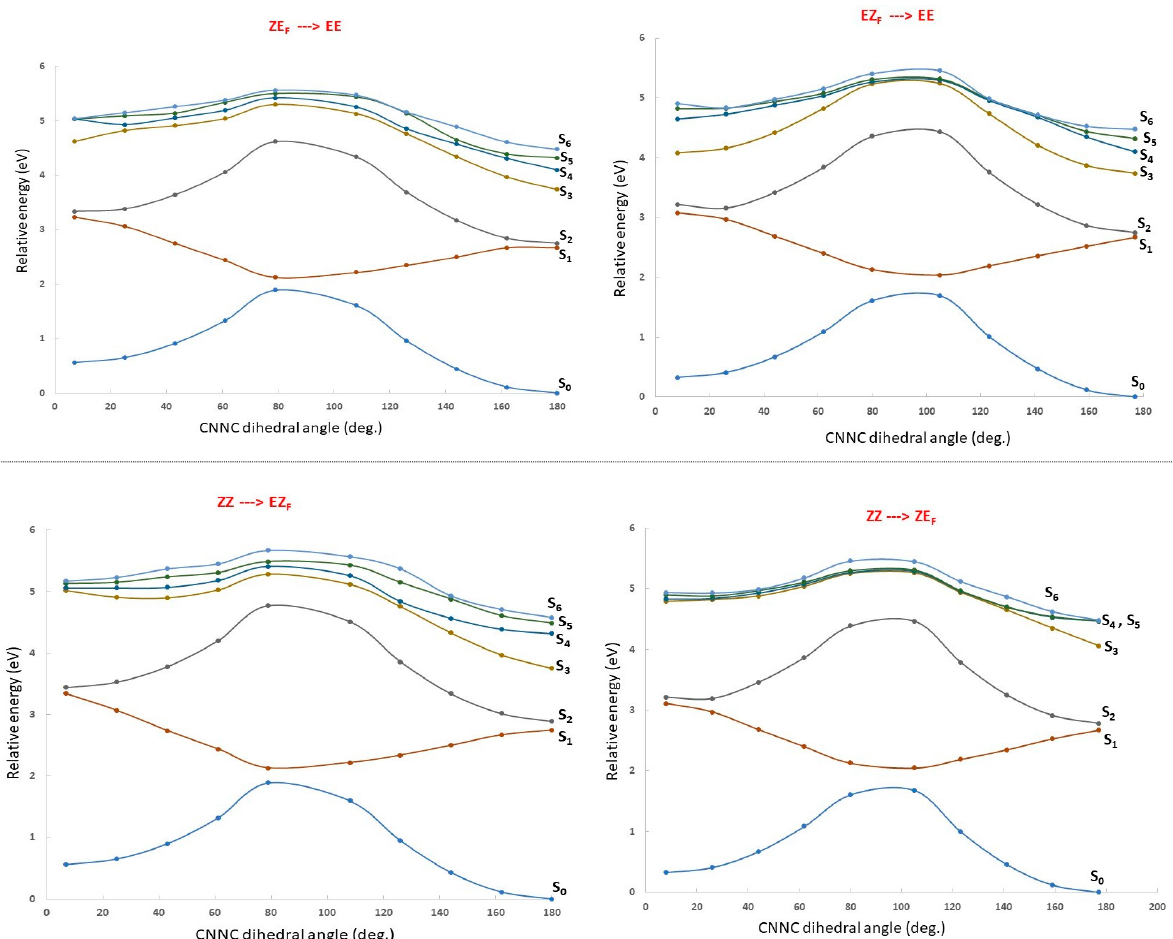
Figure 4. Relaxed scans of the potential energy surfaces of the ground electronic states along all the isomerization pathways (the CNNC dihedral angle of each azobenzene unit). At each point of the scan the energies of the lowest six excited electronic states are computed. The lines are drawn with different colors and adiabatically follow the energies of each electronic state so that they never cross. The quasi degeneracy of S 0 and S 1 right in the middle of the reaction coordinate is a clear indication of the presence of conical intersections (CIs). CIs are effective funnels that promote the radiationless deactivation of the excited state to either side of the isomeriza- tion path and so their presence is relevant in order to grasp the photochemistry of any molecule. Approximate geometries of the CIs for dimer 1 were obtained through full